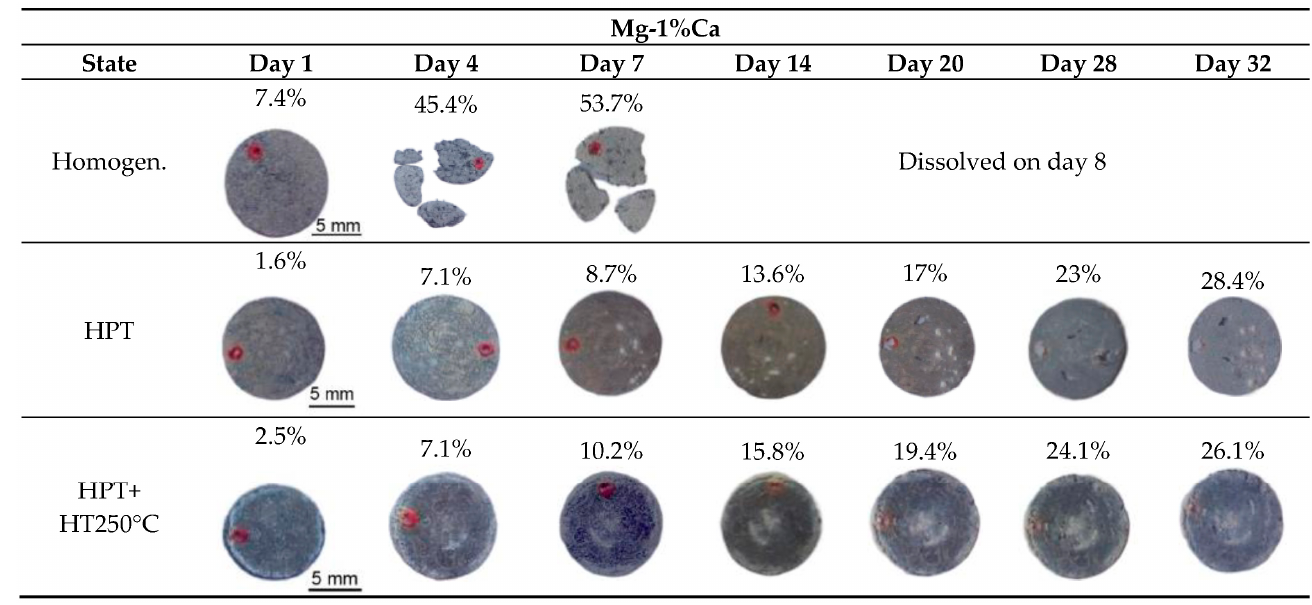
Figure 4. View of the Mg-1%Ca alloy samples (diameter 20 mm) in the homogenized state, after HPT and HPT+HT250 ◦ C during corrosion tests in Ringer’s solution; the exposure time of the samples was from 1 to 32 days (optical photographs). Table 2. Mass loss and corrosion rate of the Mg ‐ 1%Ca alloy during corrosion tests in Ringer’s solu ‐ tion.